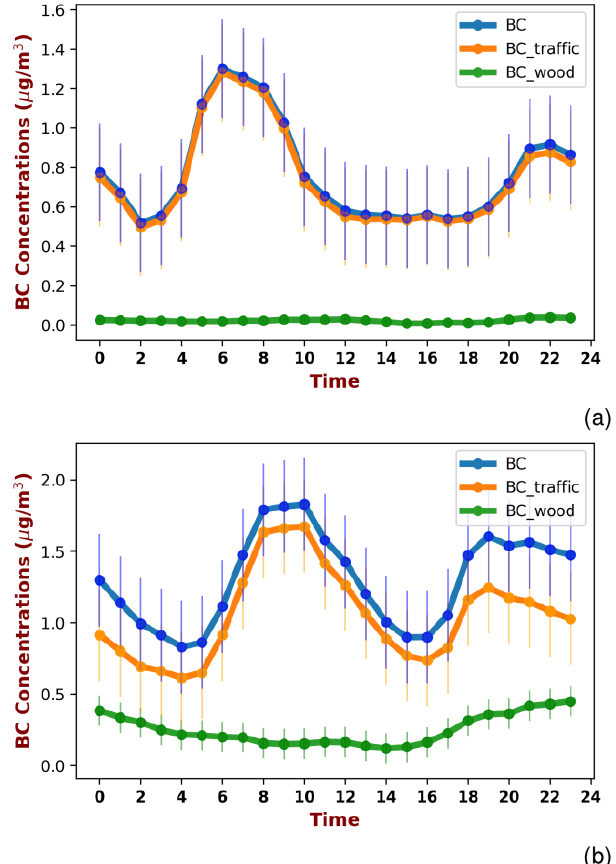
Figure 5. Diurnal mean variation and standard deviation of the BC mass concentrations (μg/m 3 ) along with the contribution of the fossil fuel and wood burning to the total BC mass concentrations, during ( a ) the summer and ( b ) winter PANACEA campaign in Thessaloniki station.